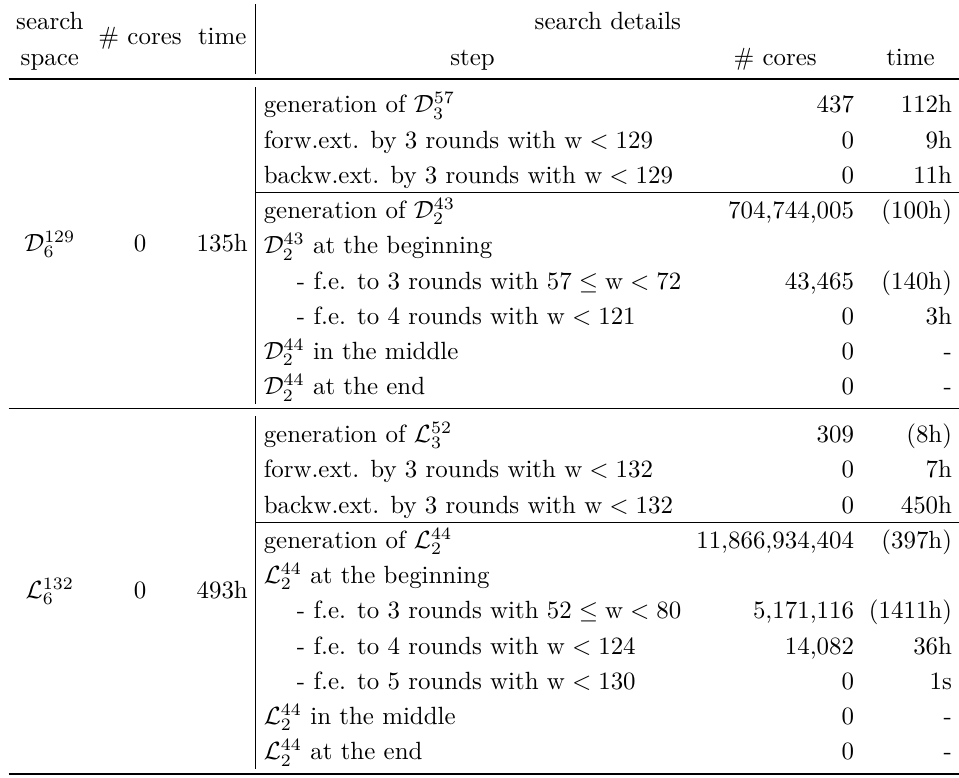
Table 6: Results on the generation of canonical 6-round differential and linear trail cores with weight lower than 129 and 132, respectively. Timings between parentheses mean that we can reuse previous results and they are not counted in the total amount of time. - means that the step was not performed, because we know it leads to an empty